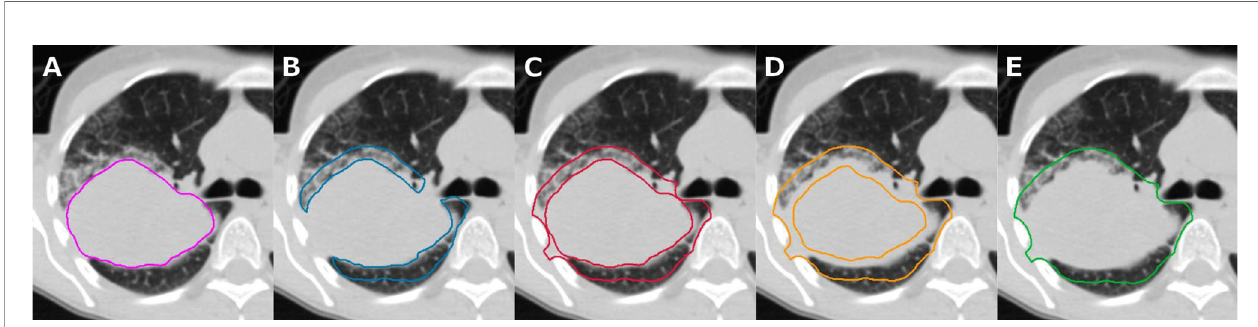
FIGURE 1 | Same axial slice of a patient in our cohort shown for tumoral and peritumoral region of interests (ROIs), i.e., visual extent of the primary tumor ( A , GTV), 0.8 cm expansion into lung tissue region inside the lung ( B , lung_exterior), 0.8 cm expansion into lung and soft tissue ( C , iso_exterior), 0.4 cm contraction and 0.8 cm expansion from the GTV ( D , gradient), and primary tumor including iso_exterior ( E ,